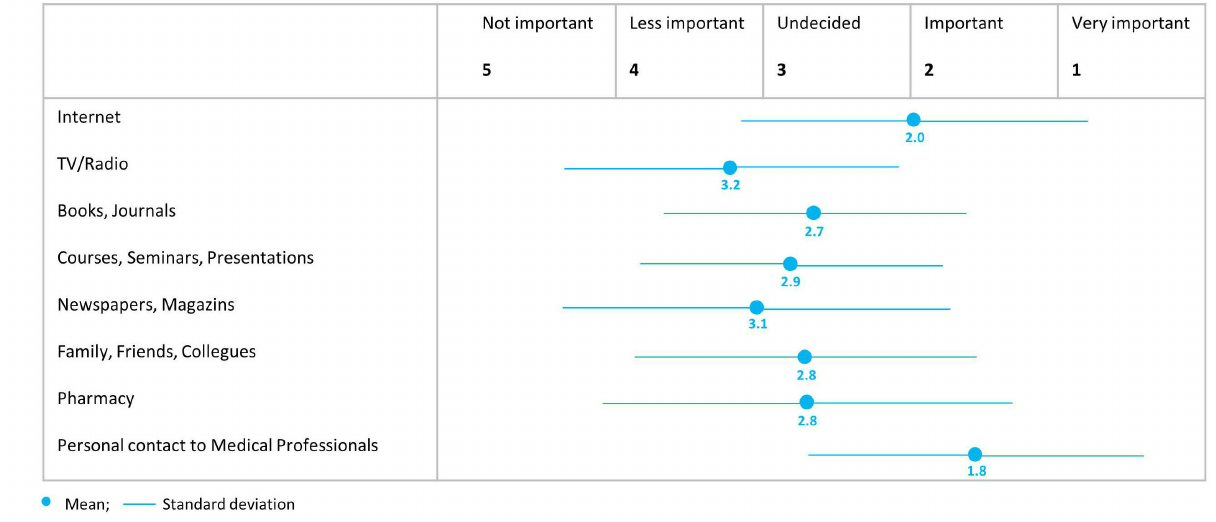
Figure 3. Importance of information sources for health-related aspects.